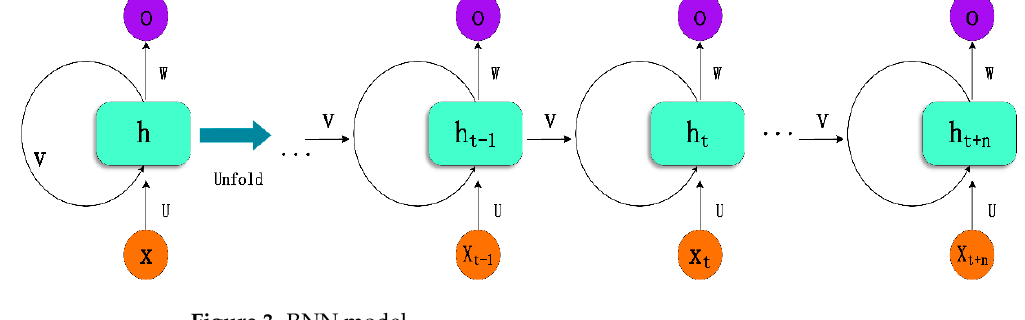
Figure 3. RNN model.